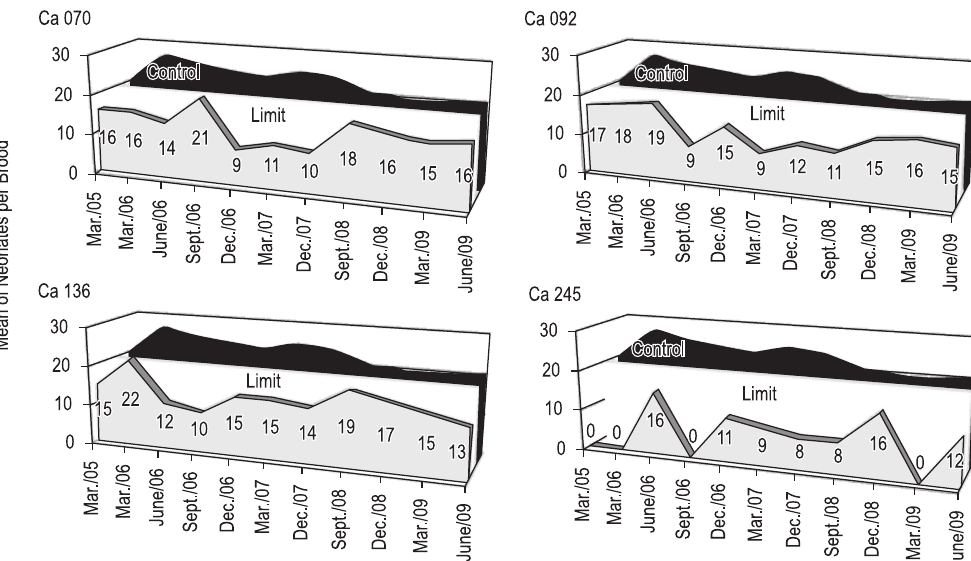
Figure 3. Mean number of neonates per Daphnia magna brood exposed to sediment samples from each